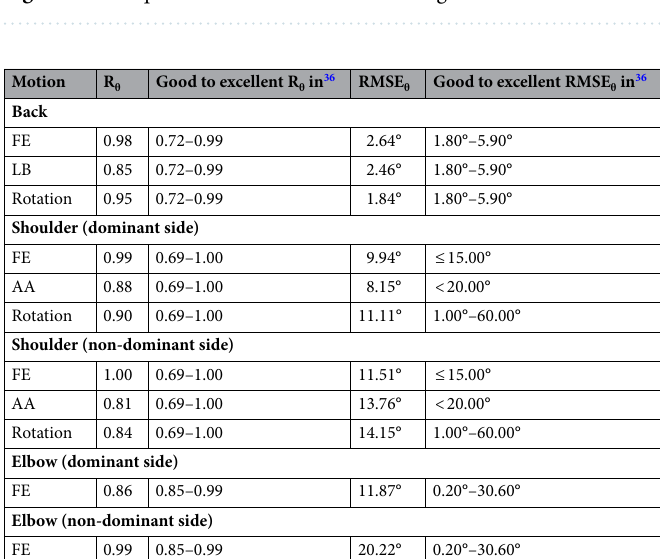
Figure 3. A sequence of the simulated harvesting motion of a harvester.